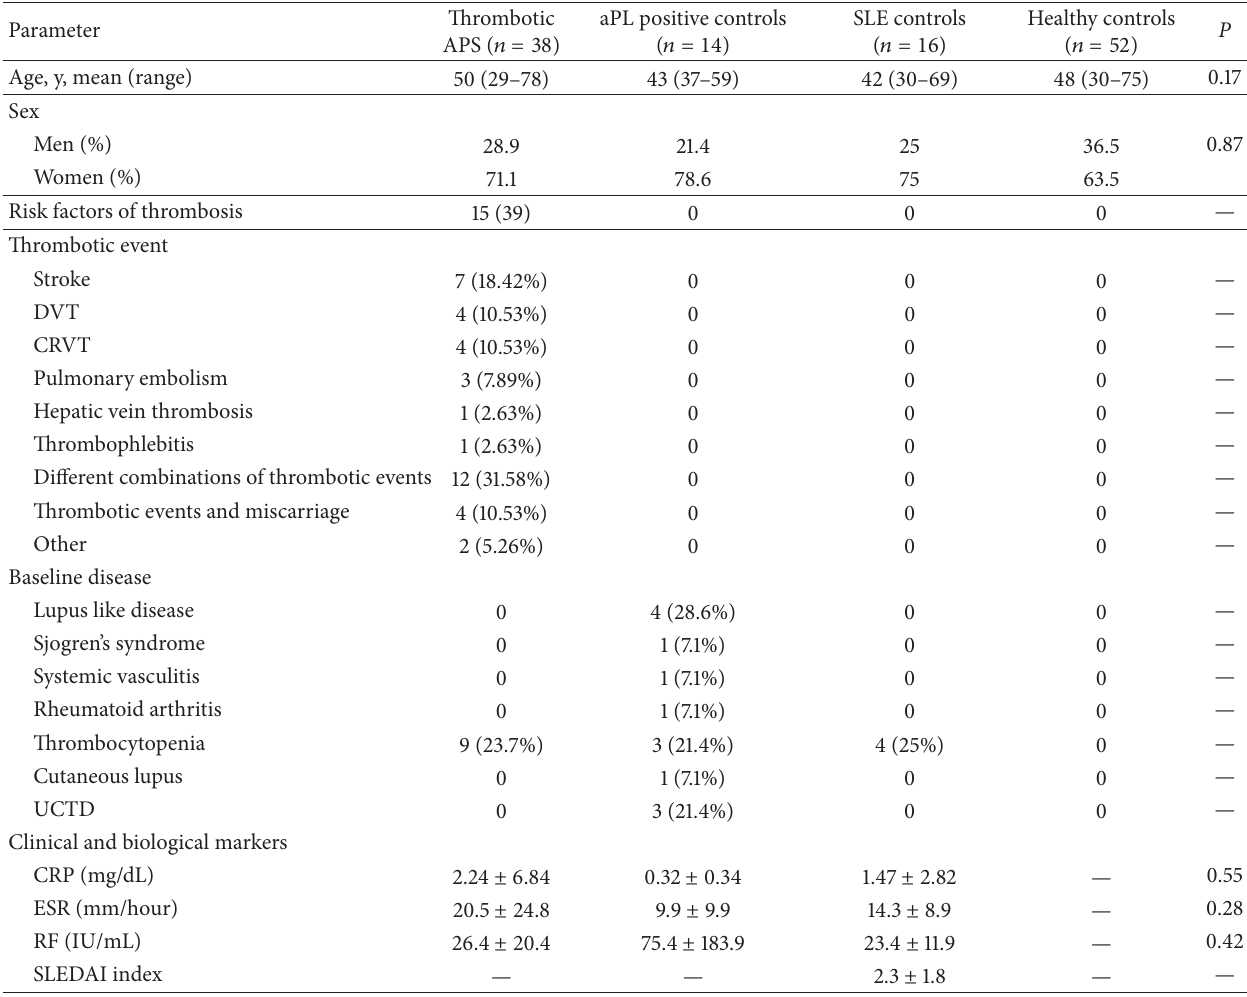
Table 1: Clinical characteristics of patients with thrombotic APS and